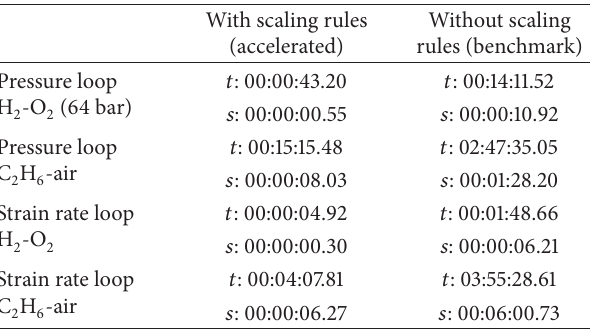
Table 3: Simulation times for the pressure loops and the average strain rate loops with and without the scaling rules